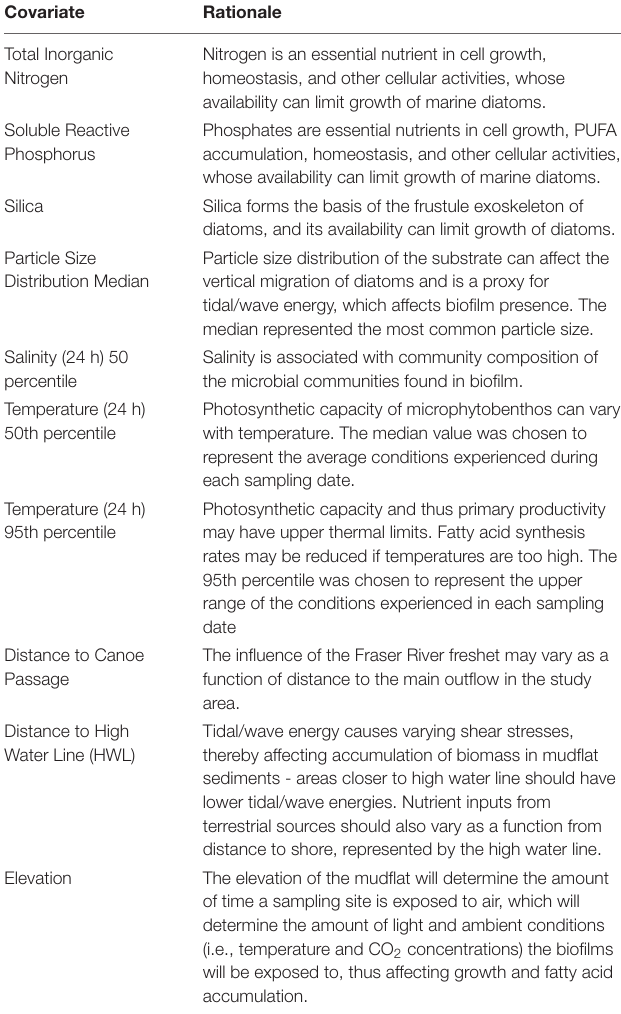
TABLE 1 | Explanatory variables for modeling spatial and temporal variation in measures of biofilm organic and fatty acid content.